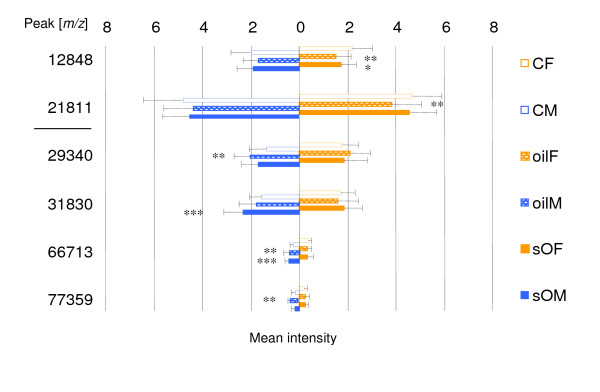
Histogram of sex dependent expression changes (intensities as arbitrary units) obtained for gills of M. edulis upon 21d exposure to 0.5 mg/L crude oil (oil) and 0.5 mg/L crude oil spiked with a mixture of APs and PAHs (0.1 mg/L; sO); CF = control females, CM = control males, sOF = spiked oil females, sOM = spiked oil males, oilF = oil females, oilM = oil females; males are depicted as blue and females as orange; the upper two represent female-specific and lower four male-specific peaks. Significantly different at 0.05 ≥ p ≥ 0.01, **, at 0.01 ≥ p ≥ 0.001, ***, at p < 0.001.